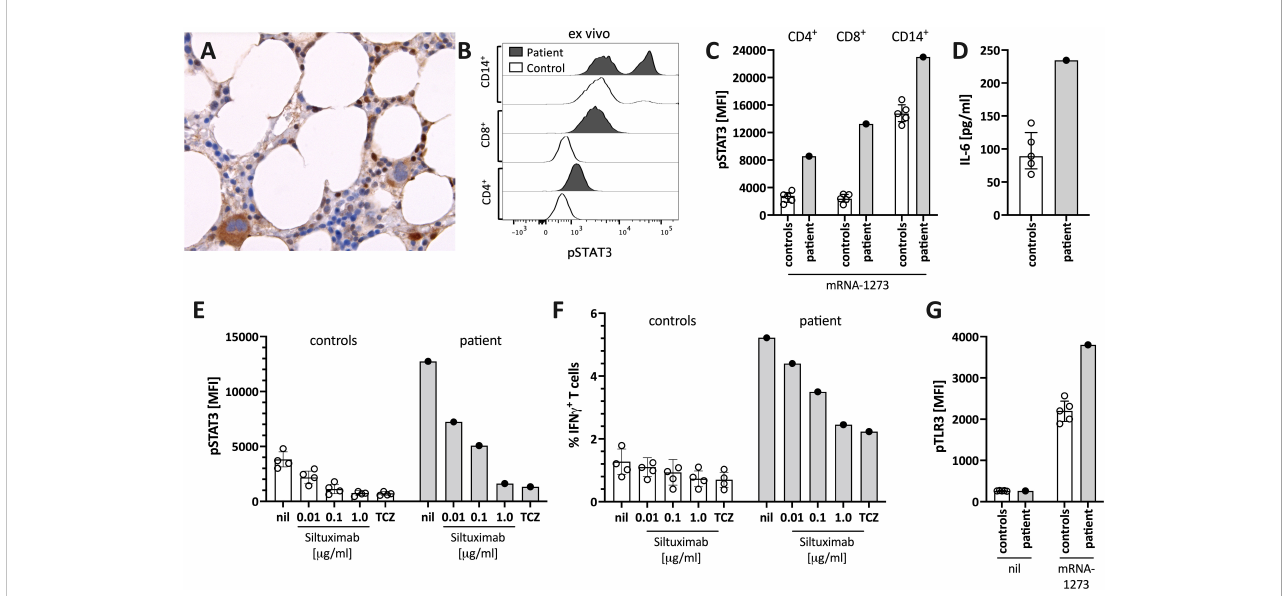
FIGURE 3 Enhanced STAT3/IL-6 pathway activation in the bone marrow and in vitro by mRNA-1273 stimulation. (A) Immunohistochemical staining for phosphorylated-STAT3 (pSTAT3) showing scattered positive interstitial cells, morphologically consistent with lymphocytes, suggestive of STAT3 activation at diagnosis; note the negatively staining erythropoiesis and the nuclear negativity of the megakaryocytes. Immunoperoxidase staining; original magni fi cation 630x. (B) Histogram showing pSTAT3 in T cells (CD4 + and CD8 + ) and monocytes (CD14 + ) directly ex vivo . (C) STAT3 phosphorylation (pSTAT3) following in vitro stimulation of peripheral blood immune cells with the mRNA-1273 vaccine. (D) Supernatants of PBMC stimulated with mRNA- 1273 show higher IL-6 production (ELISA). (E) mRNA vaccine induced in vitro STAT3 phosphorylation was dose-dependently blocked by the anti-IL-6 antibody siltuximab and the IL-6 receptor blocker tocilizumab (TCZ; used at 30 m g/ml, which corresponds to the serum concentration of treated subjects (see also Supplementary Figure S2). (F) mRNA stimulation induced T cell activation, as indicated by IFN g positive T cells, was inhibited by IL-6 blockade (siltuximab or TCZ). (G) mRNA-1273 stimulation resulted in TLR3 phosphorylation in monocytes of healthy controls, and even more pronounced of the patient. MFI= median fl uorescence intensity in fl ow cytometry. nil= only mRNA-1273 without other blocking conditions; ctrl, healthy controls; px,